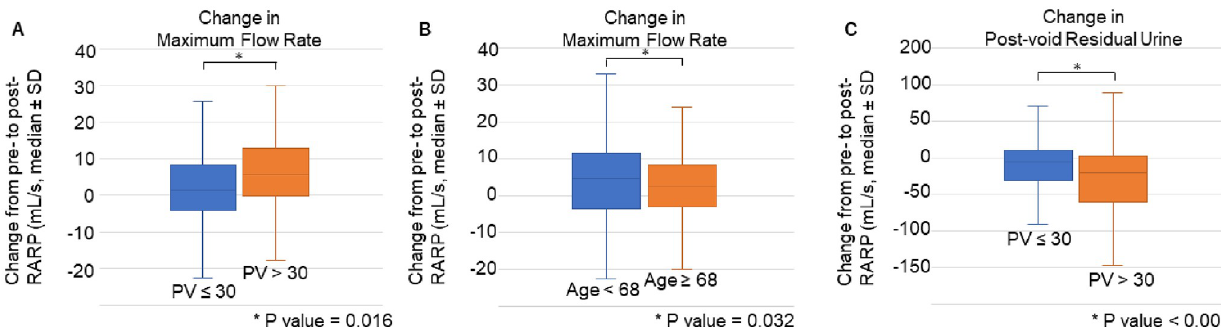
Fig 3. Changes in uroflowmetry results stratified by predictive factors. Box-plots of (A) perioperative change in maximum flow rate when stratified by prostate volume, (B) perioperative change in maximum flow rate when stratified by age, and (C) perioperative change in post-void residual volume when stratified by prostate volume. Median, interquartile, and standard deviation are shown. A significant difference was seen in each parameter when stratified by their respective predictive factors. Abbreviations RARP: robot-assisted radical prostatectomy, PV: prostate volume.